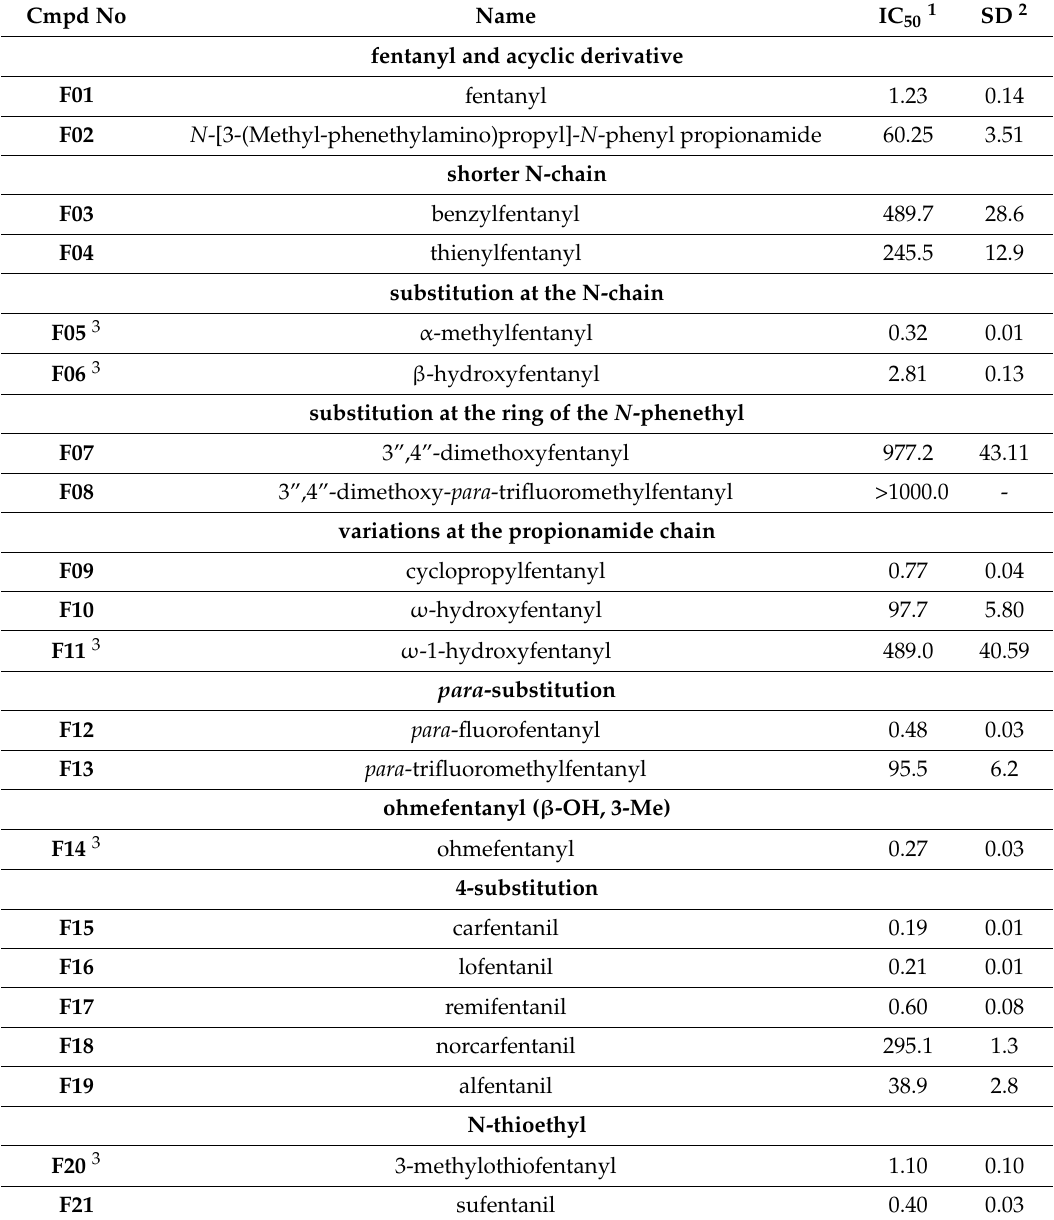
Table 1. IC 50 values from competitive radioligand displacement assay for the derivatives under the